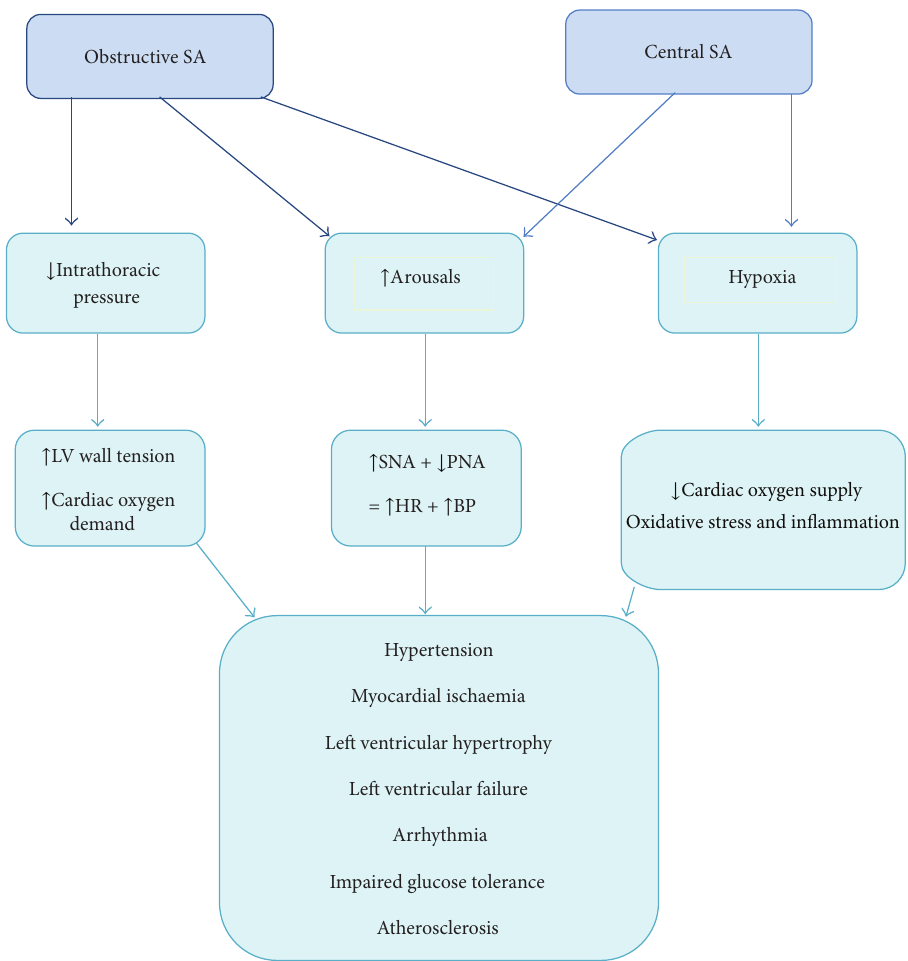
Figure 2: Summary of the physiological mechanisms contributing to cardiovascular disease in SDB. SA: sleep apnoea; SNA: sympathetic nervous activity; PNA: parasympathetic nervous